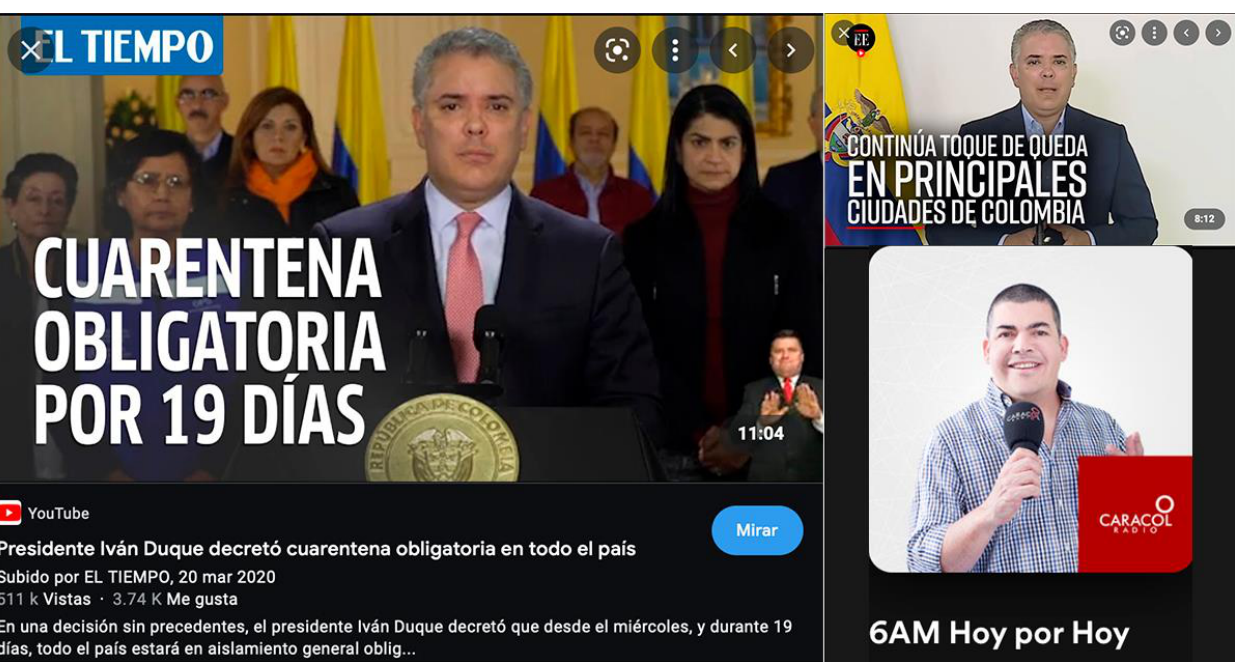
Figure 7. Appropriation of alternative broadcast scenarios by the media. Prepared by the author with images taken from social networks.